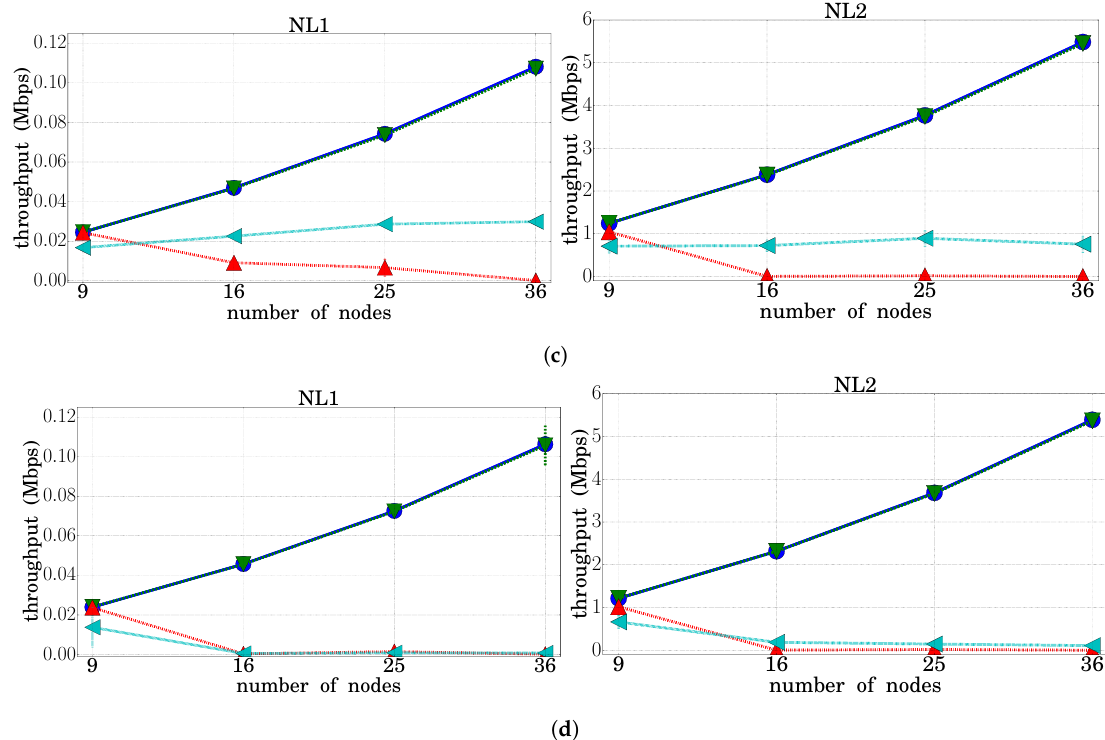
Figure 8. Throughput (HWMP vs. MPC-HWMP). ( a ) Traffic Type 1; ( b ) Traffic Type 2; ( c ) Traffic Type 3; ( d ) Traffic Type 4.